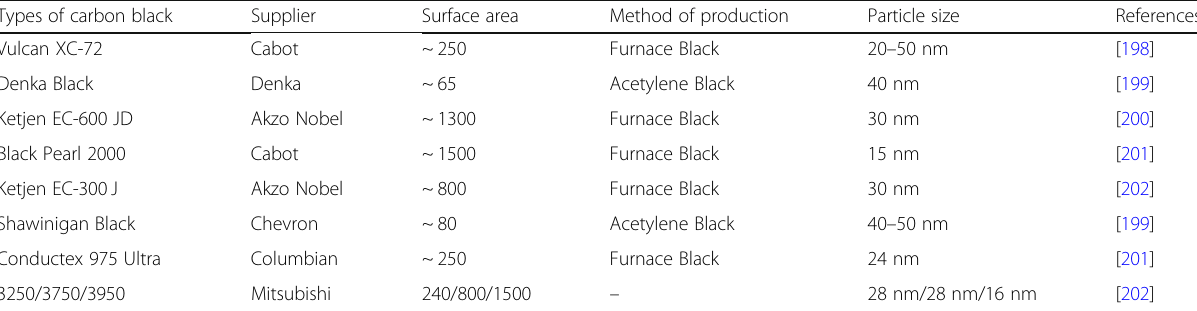
Table 3 Properties of carbon black